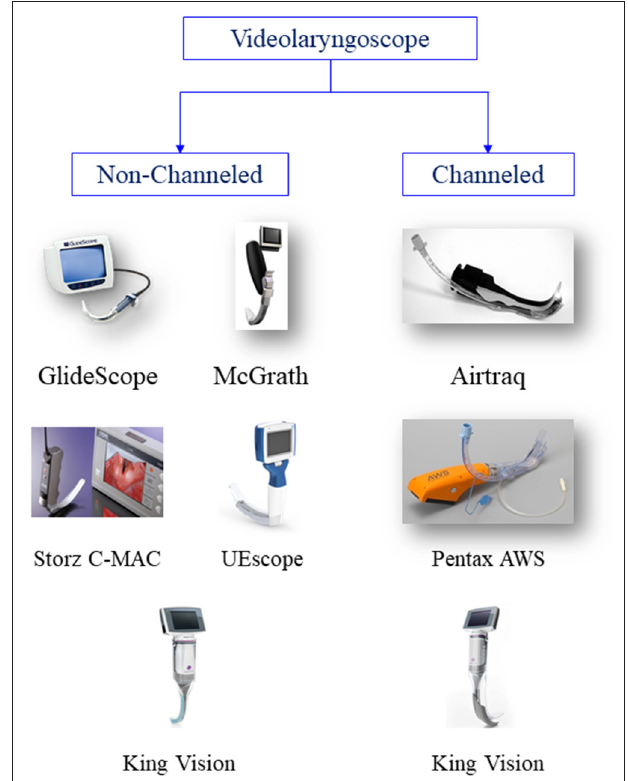
FIGURE 1 | Classfication of videolaryngoscopes. GlideScope image courtesy of Verathon, USA. McGrath series 5 image courtesy of Aircraft Medical, UK. Airtraq image courtesy of Prodol Meditec, Spain. C-MAC image courtesy of KARL STORZ Endoscopy, Germany. UEscope image courtesy of UE Medical Corp, China. Pentax AWS, King Vision image courtesy of Ambu USA. Part of this figure is taken from Healy et al BMC Anesthesiol. 2012; 12: 32. ©